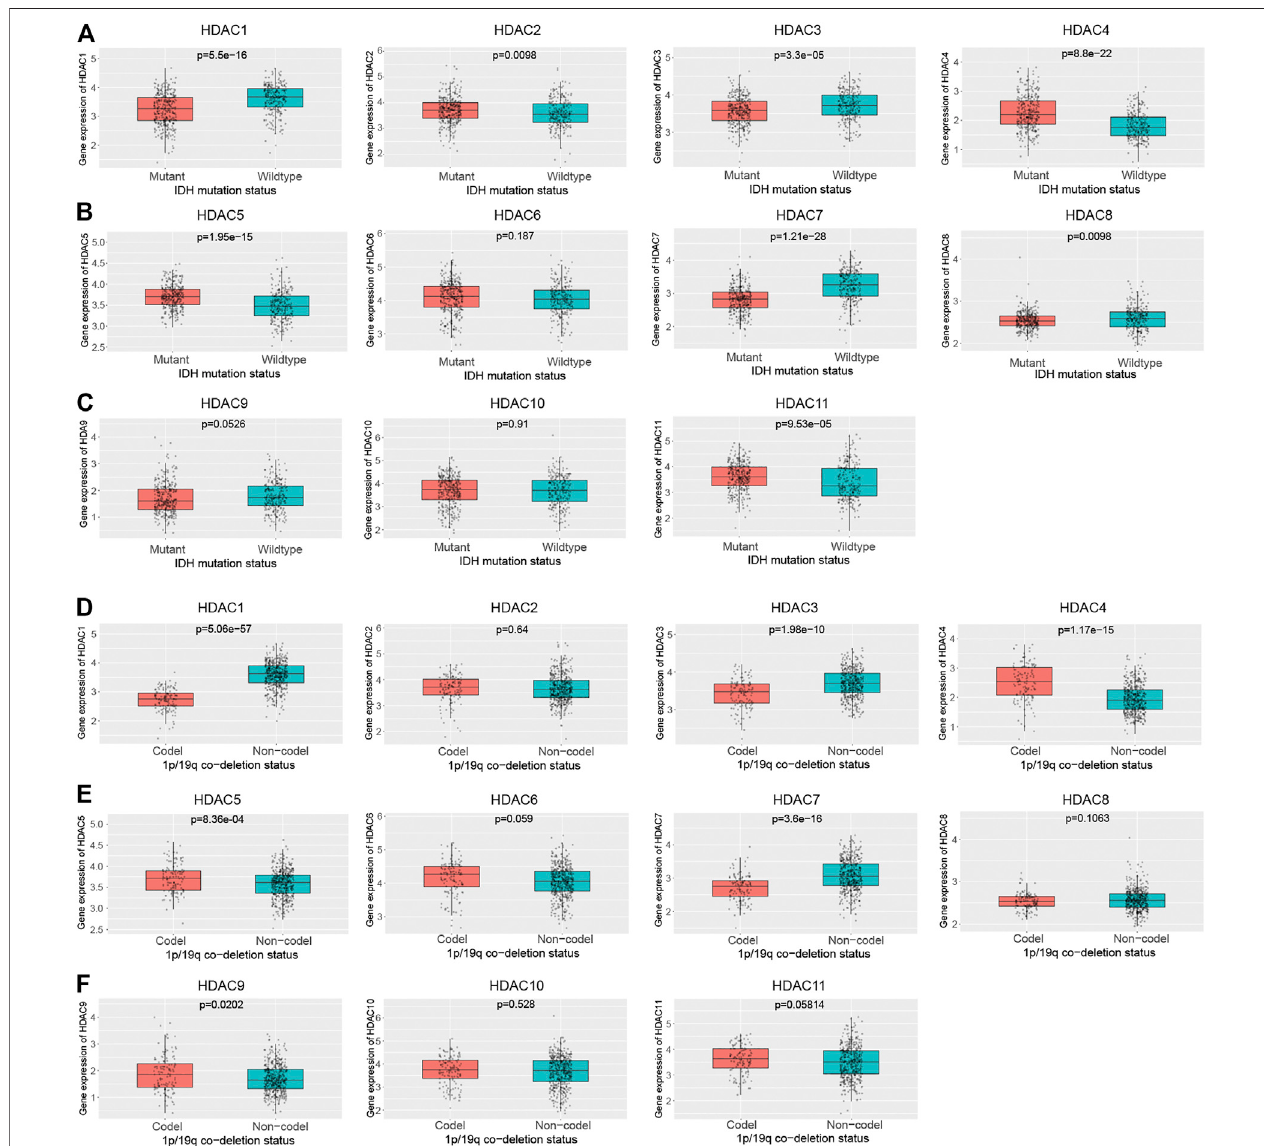
FIGURE 4 | Correlation between HDAC family and glioma genetic mutation in CCGA. (A – F) The box plots showed that the expression of the HDAC family varied according to the glioma mutations.